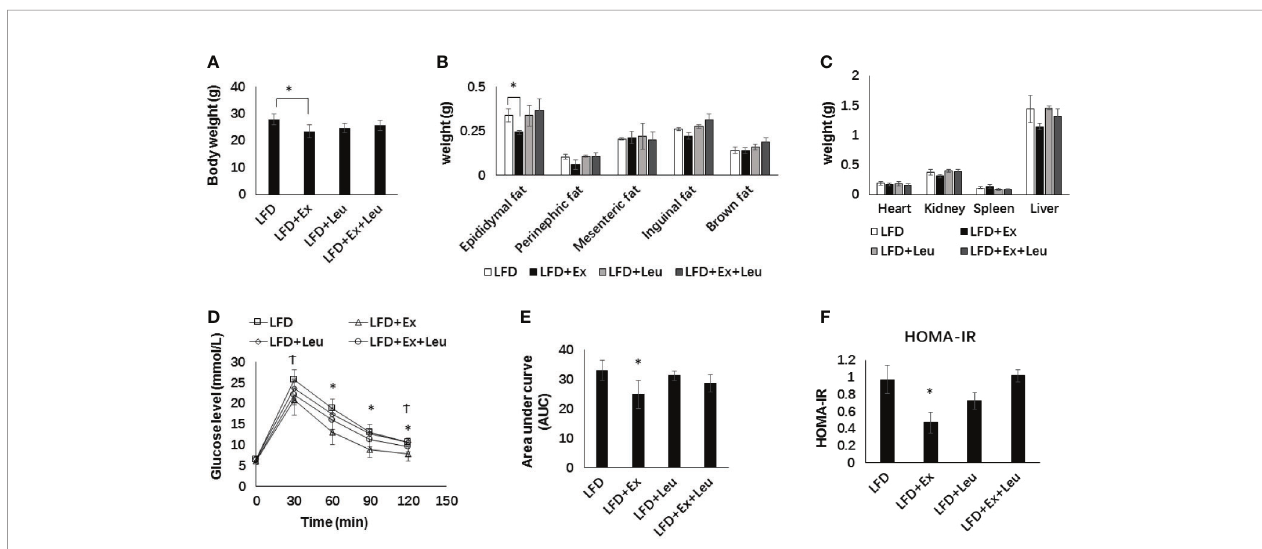
FIGURE 1 | Exercise intervention reduced fat content and improved insulin sensitivity under LFD. C57BL/6J male mice of 5 – 6 weeks were fed with LFD. Leucine with a concentration of 1.5% and/or moderate intensity exercise was added in the 10th week and administrated for 4 weeks. (A) Changes in body weight. (B) Changes in fat content. (C) Changes in organ weight. (D) Glucose tolerance test (GTT). Mice were fasting overnight; D-glucose (2 g/kg) was injected intraperitoneally. Blood glucose concentration was detected 0 min before injection and 30, 60, 90, and 120 min after injection. (E) Area under curve of GTT. (F) HOMA-IR. Calculated based on fasting glucose level (mmol/L) and fasting insulin level ( m U/ml). The data are mean ± s.d. (error bars), n = 6 mice per group. *p < 0.05 LFD versus LFD + Ex; † , p < 0.05 LFD versus LFD + Ex + Leu.